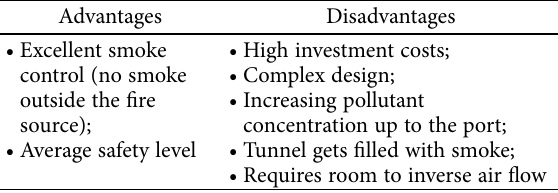
Table 2. Axial fans with Saccardo nozzle ( A 2 )